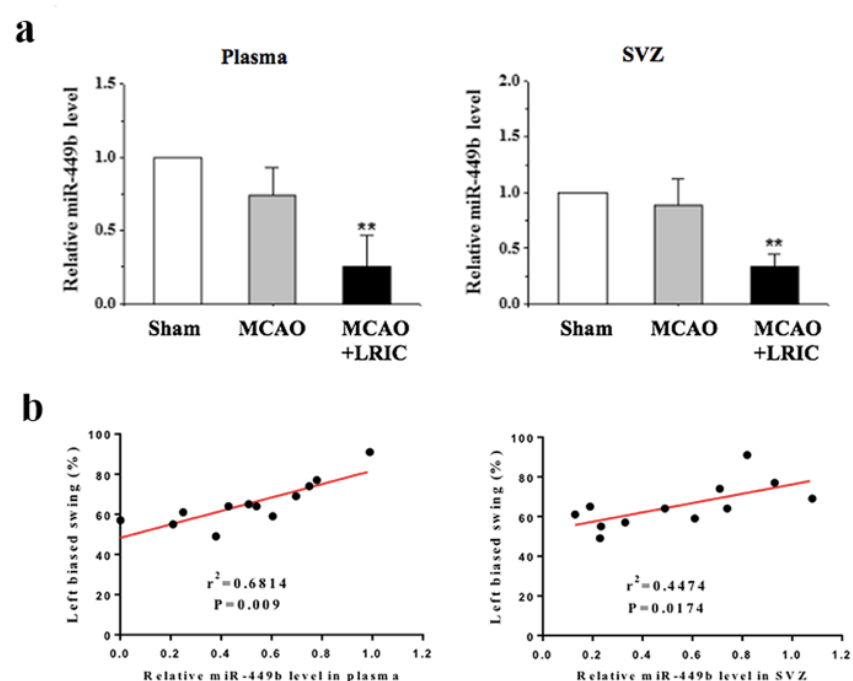
Figure 6. LRIC down-regulated the expression of miR-449b in plasma and SVZ. ( a ) The graph shows the level of miRNA-449b in the plasma and SVZ. N = 8/each group. ** p < 0.01. ( b ) Pearson correlation between left biased swing at 28 days after MCAO and number of BrdU-positive/DCX-positive cells.